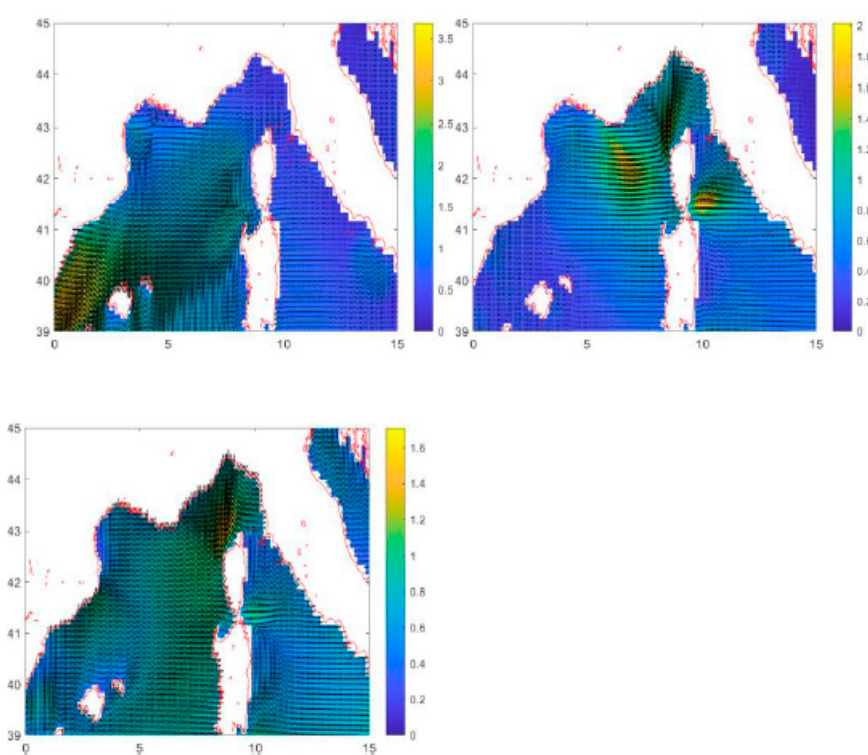
Figure 3. March–April–May. Source: Ship weather routing software, output, Authors (2020).